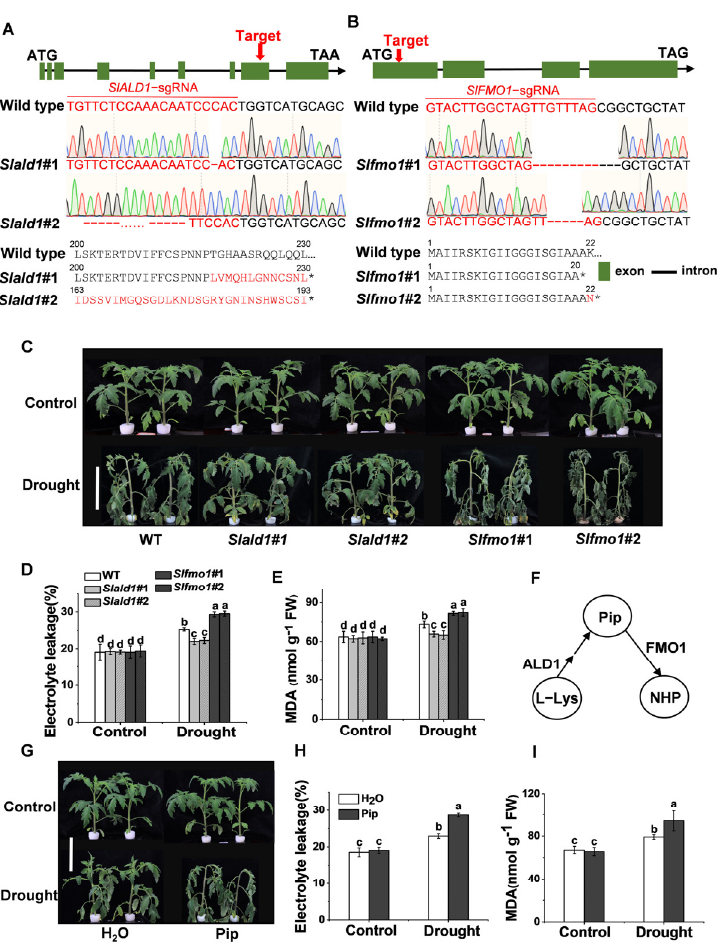
Figure 2. Effects of drought stress on Slald1 and Slfmo1 mutants. ( A ) Schematic illustration of the sgRNA target site (red arrows), DNA sequencing peak map, and protein sequence in wild-type (WT) SlALD1 and two alleles ( Slald1 #1 and Slald1 #2) from CRISPR-Cas9 T2 mutant lines. ( B ) Schematic illustration of Slfmo1 #1 and Slfmo1 #2. ( C ) Representative images of Slald1 , Slfmo1 mutants and WT plants. Bar = 10 cm. The mutants and WT plants were subjected to control or drought treatment, and the plant images were taken 48 h later. ( D ) The relative electrolyte leakage of tomato leaves after 48 h of control and drought treatments. ( E ) The membrane lipid peroxidation product MDA accumulation in tomato leaves after 48 h of control and drought treatments. ( F ) Schematic illustration of Pip biosynthesis and downstream N-hydroxylated modification. ( G ) Representative images of plants pretreated with H 2 O and 1 mM Pip under control and drought treatments. Bar = 10 cm. Plant images were taken 48 h later. ( H ) The relative electrolyte leakage of tomato leaves after 48 h of control and drought treatments. ( I ) MDA content in tomato leaves after 48 h of control and drought treatments. The data are presented as mean values ± SD, n = 4. Different letters (a, b, c, d) above each bar indicate significant differences at p < 0.05 (Tukey’s test) among